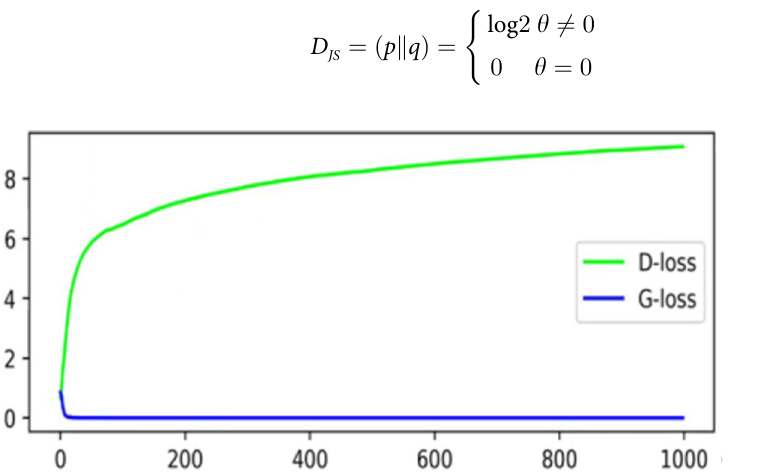
Fig 3. SRGAN training process appears mode collapse. D-loss is the generator loss, and G-loss is the generator loss. During the training process, the D-loss does not decrease in 1000 epochs.